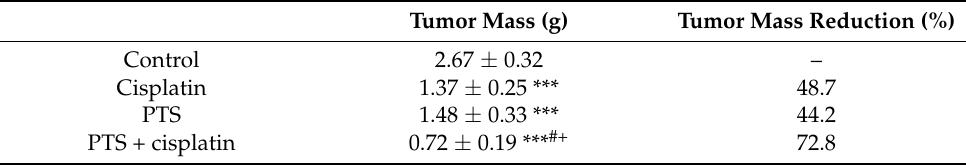
Table 1. Tumor masses after excision from sacrificed BALB/cByJNarl